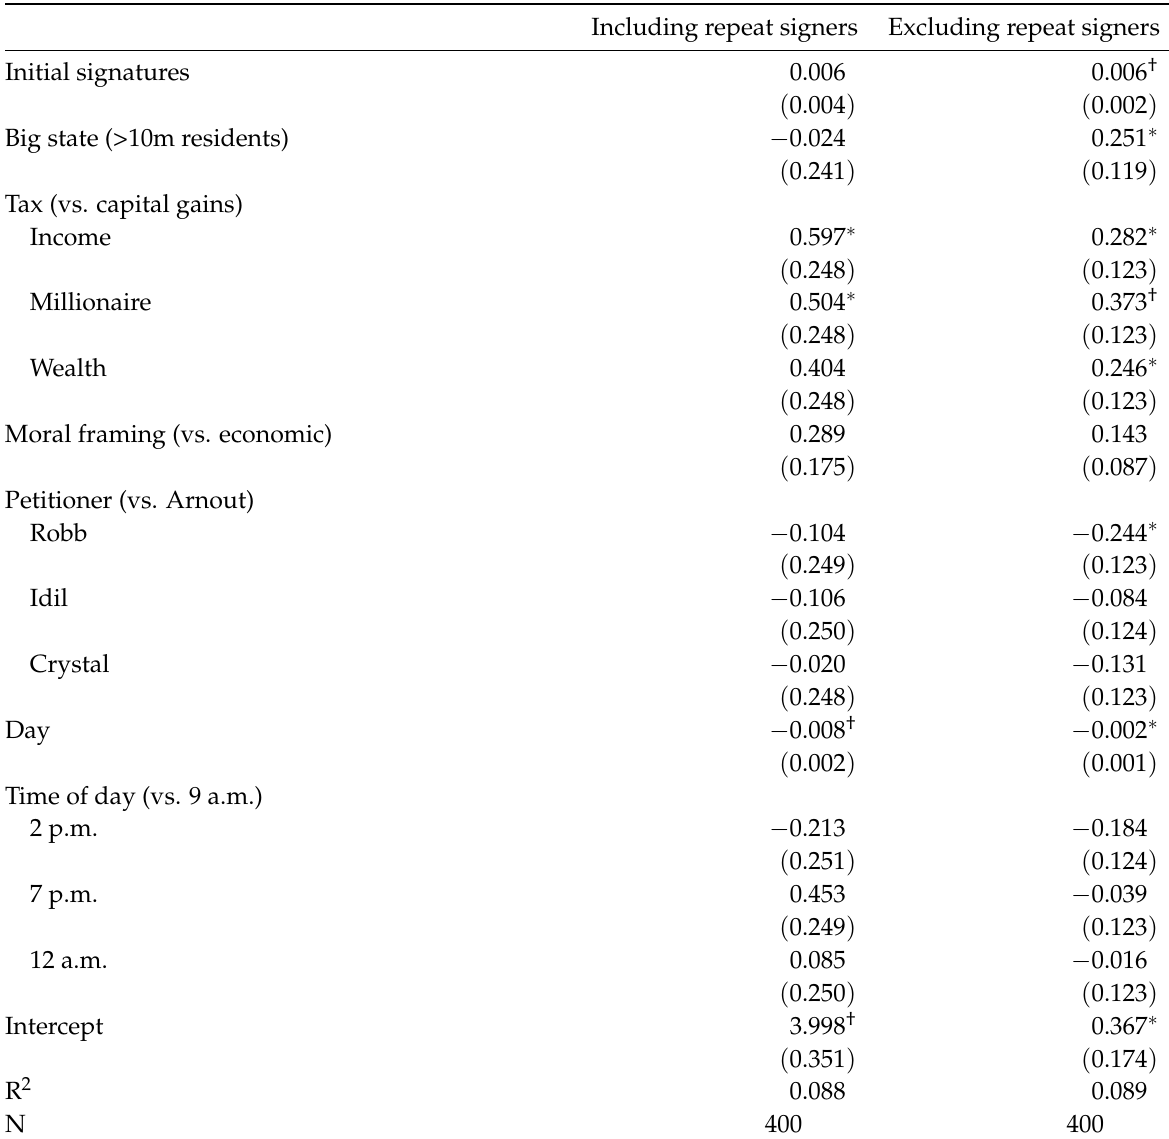
Table 2: Results of multiple regression of third-party signatures accumulated by 400